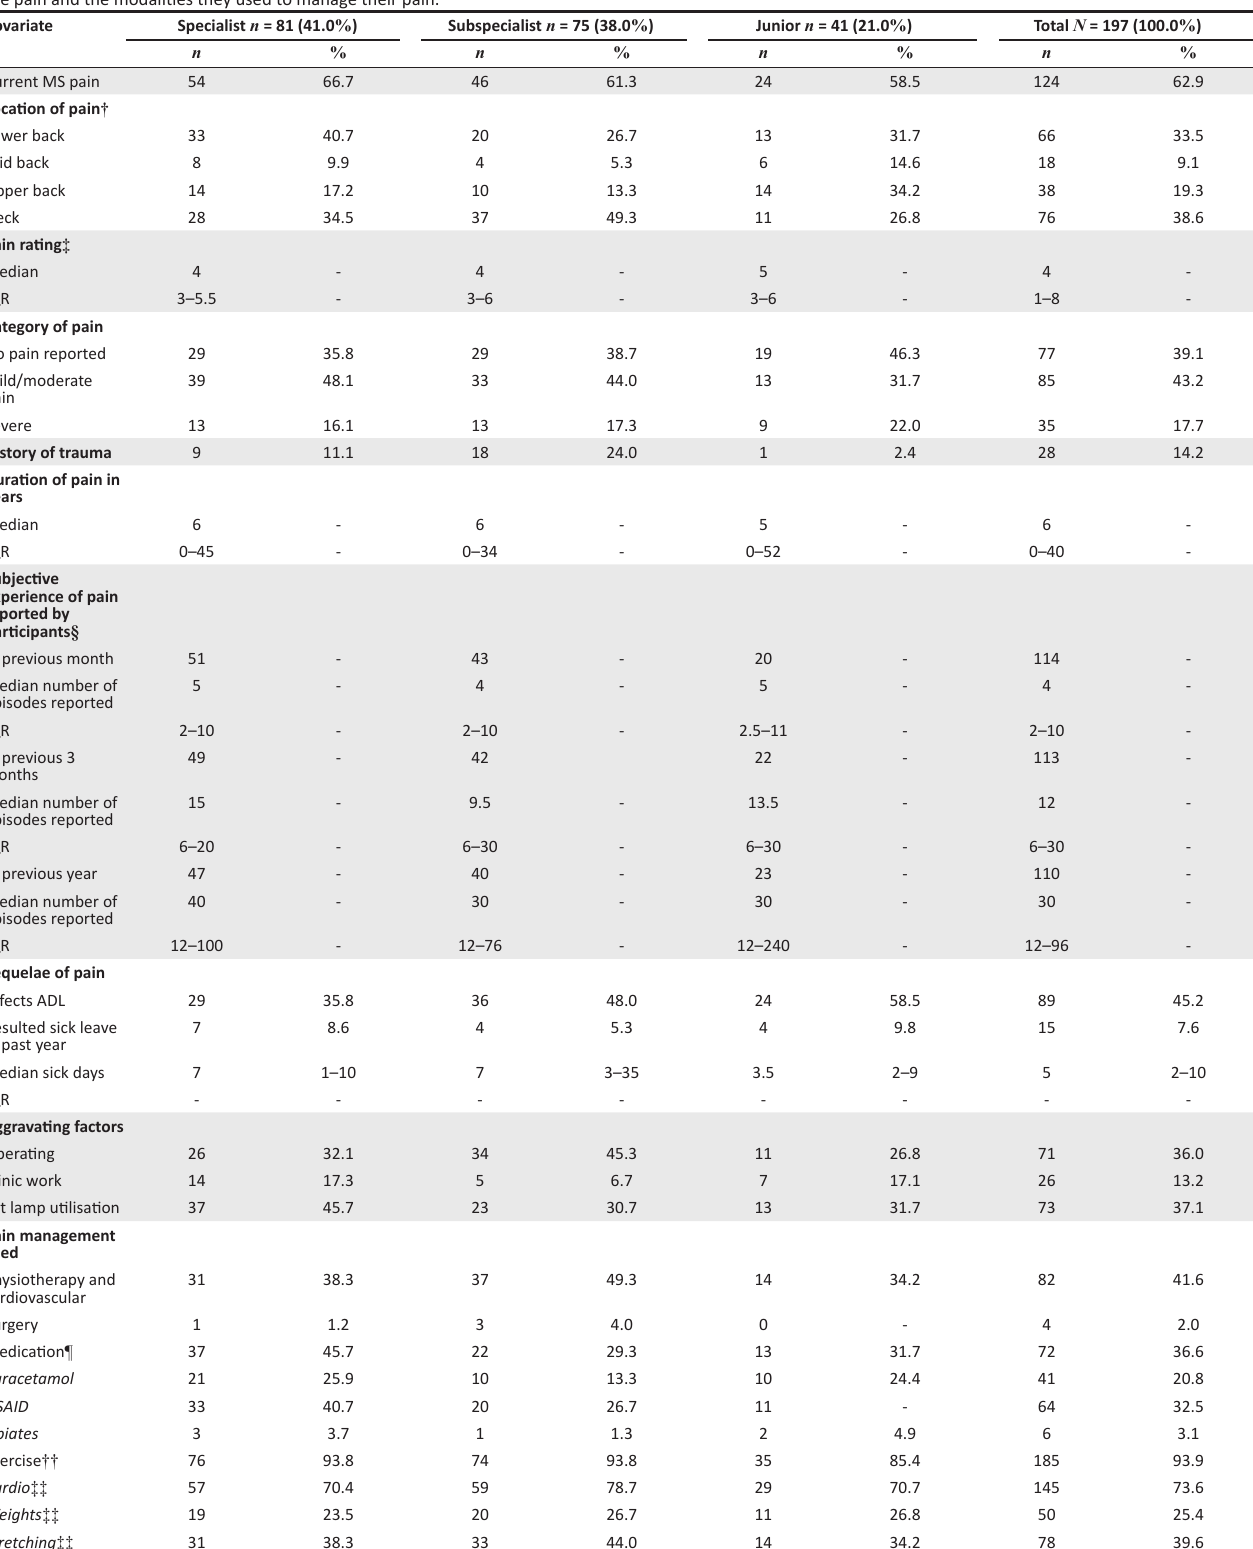
TABLE 2 : Muscular skeletal pain experienced by the 197 doctors working in ophthalmology, the characterisation of their pain and the factors that aggravated and relieved the pain and the modalities they used to manage their pain. Covariate Specialist n = 81 (41.0 % ) Subspecialist n = 75 (38.0 % )